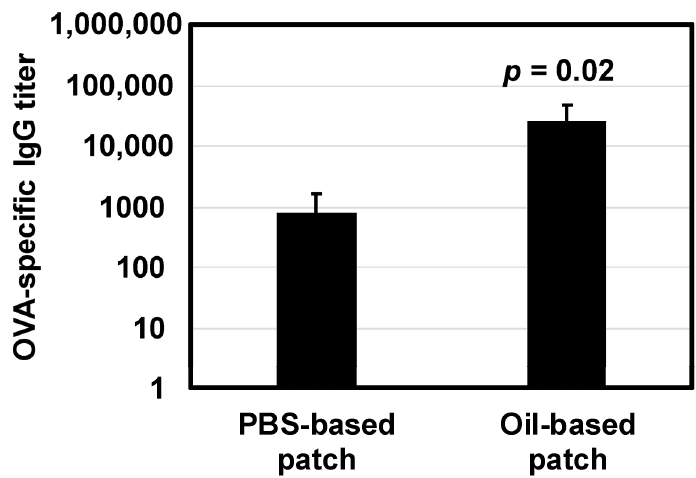
Figure 6. Antigen-specific antibody responses in mouse sera treated with a PBS-based ovalbumin (OVA) patch, and oil-based OVA patches ( n = 6). Data was showed as an average and a standard deviation.